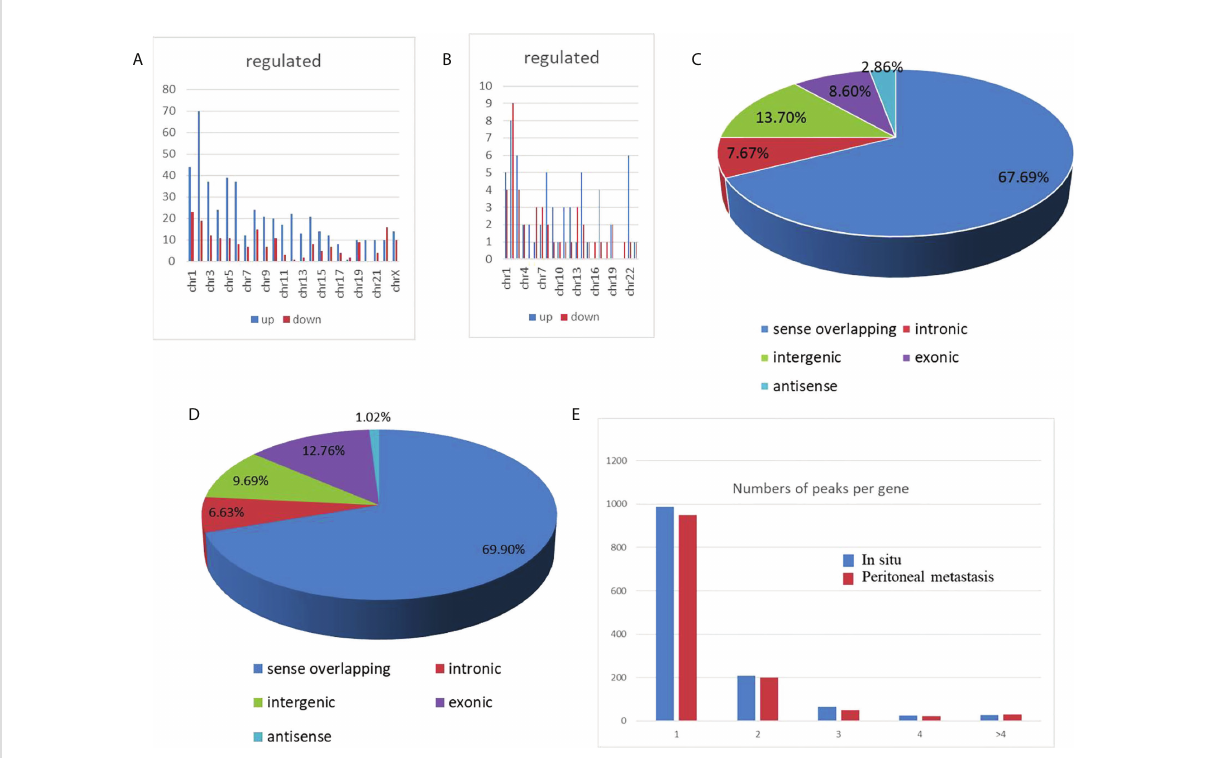
FIGURE 3 Chromosomal and genomic distributions of circRNAs. (A) Chromosomal distribution of differently m 6 A-modi fi ed circRNA peaks. (B) Chromosomal distribution of differently expressed circRNAs. (C) Genomic distribution of differently m 6 A-modi fi ed circRNA peaks. (D) Genomic distribution of differently expressed circRNAs. (E) The m 6 A peak numbers per